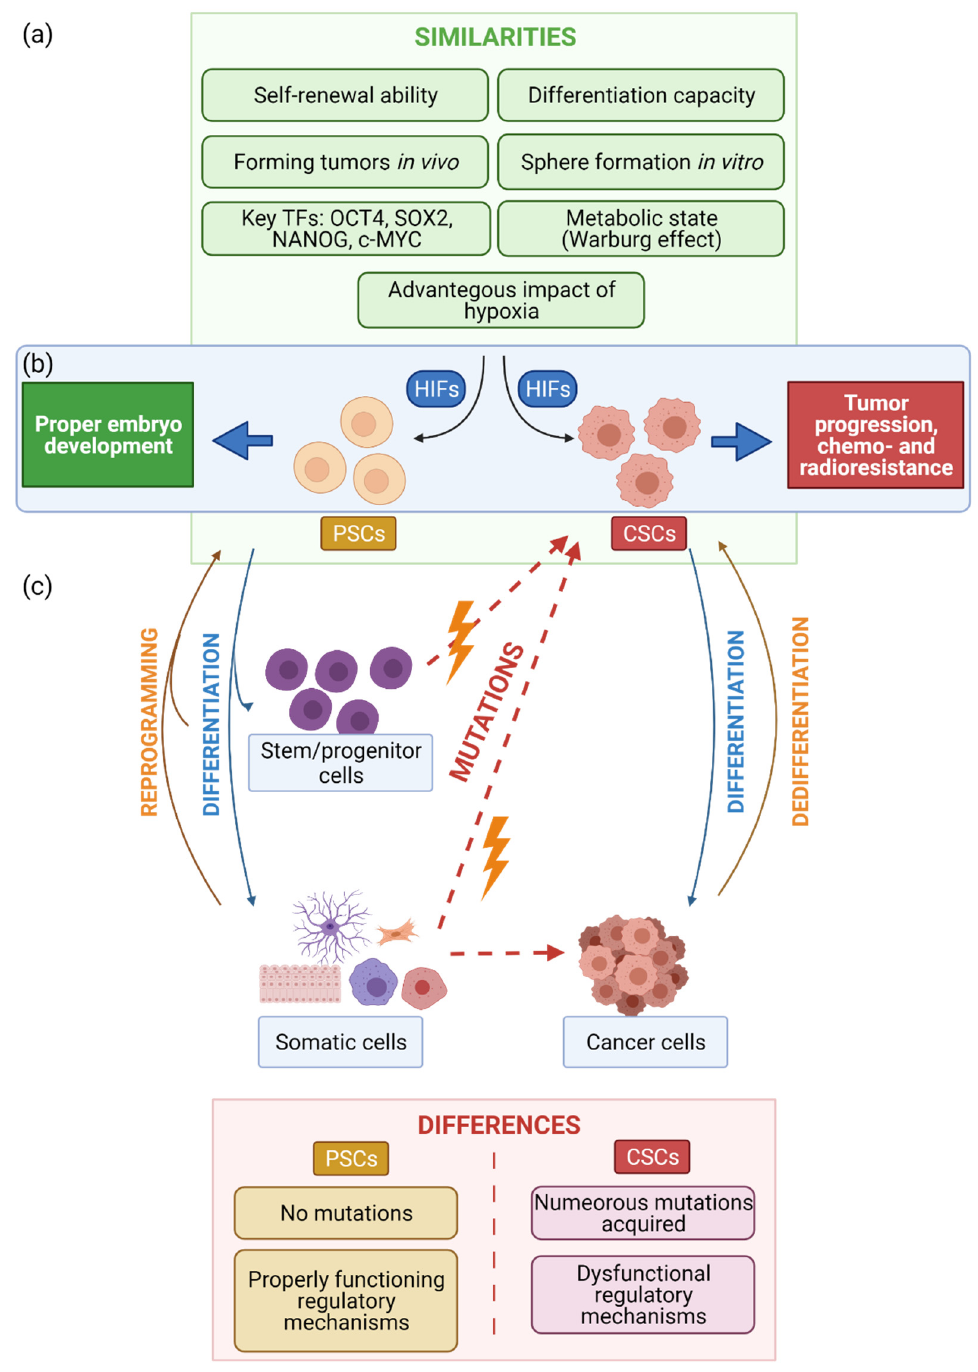
Figure 6. Comparison of PSCs and CSCs. ( a ) Similarities. Both PSCs and CSCs can self-renew and differentiate into other cell types. They can both form spheres in vitro and tumors in vivo. Their function is regulated by a similar set of transcription factors (OCT4, SOX2, NANOG, c-MYC), and they both rely on glycolysis as the main source of ATP production. ( b ) Diverse impact of hypoxia on PSCs and CSCs. Although oxygen concentration is an important factor for the function of both CSCs and PSCs, it leads to distinct effects. In the case of PSCs, hypoxia supports the state of pluripotency and proper embryo development. In contrast, a low oxygen condition in CSCs promotes tumor progression and radio- and chemoresistance. ( c ) Substantial differences between CSCs and PSCs. The regulatory mechanisms in PSCs are functional. In contrast, such mechanisms are dysregulated in CSCs due to mutations, which drive further mutagenesis and excessive